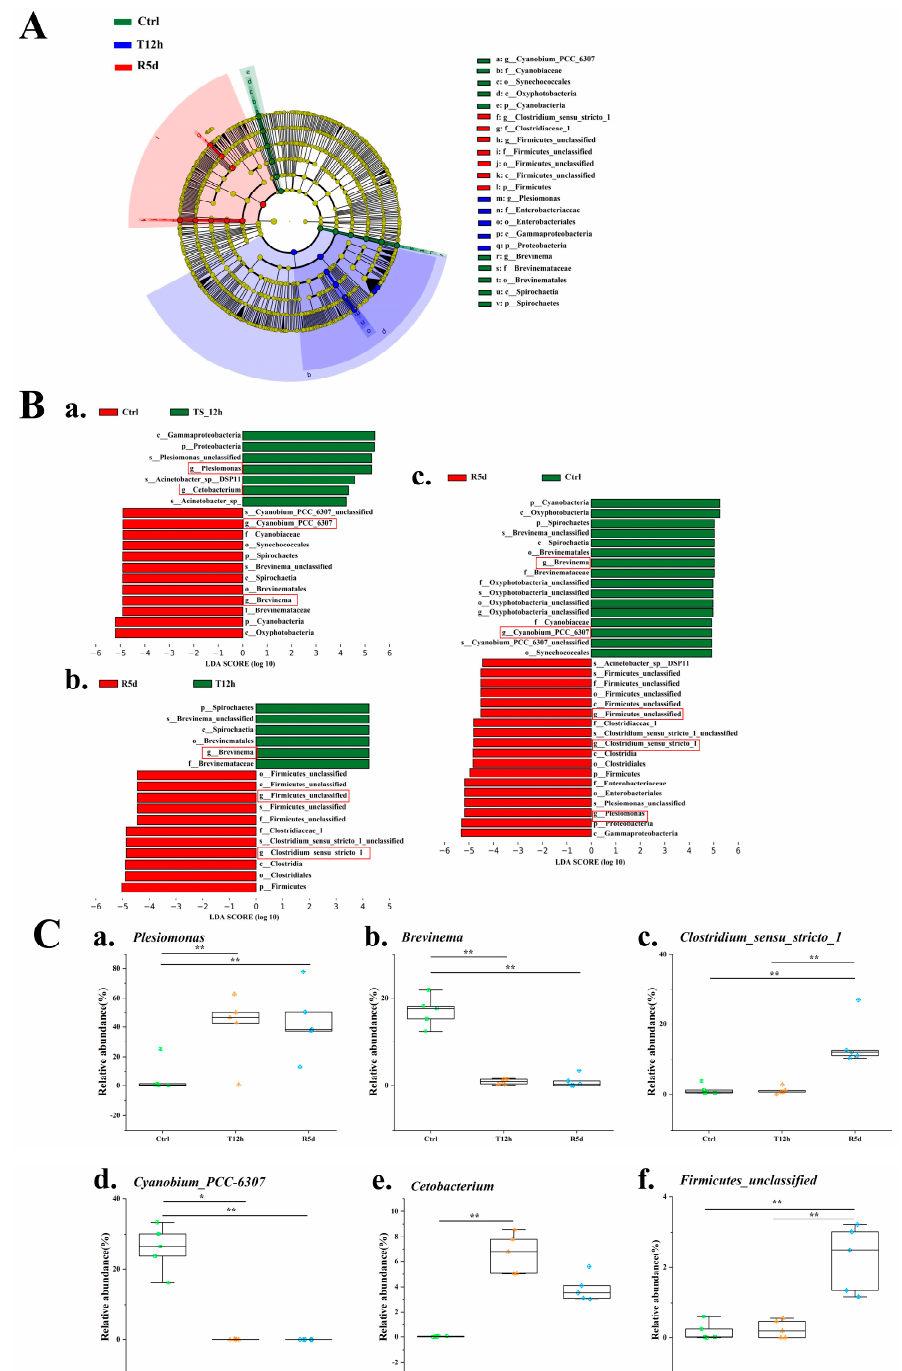
Figure 6. Linear discriminant analysis effect size (LEfSe) analysis comparing abundances of bacterial taxa in the control (Ctrl), 12 h transport (T12h) and recovery (R5d) groups. The LDA score >4. ( A ) Cladogram based on LEfSe analysis. Green, blue and red represent taxa enriched in the Ctrl, T12h and R5d groups. ( B ) Bacterial taxa with different abundances among groups. ( a ) Ctrl vs. T12h, ( b ) Ctrl vs. R5d, ( c ) T12h vs. R5, and ( d ) by Kruskal–Wallis test. ( C ) Relative abundances of dominant bacteria at the genus level ( a – f ) in the Ctrl, T12h and R5d groups. *, **: significant differences between the control and treatment groups (Kruskal–Wallis H test, *: p < 0.05, **: p < 0.01). Bacteria with significant changes in abundance were used to analyze the correlations with intestinal SOD, MDA, villus length and muscle layer thickness. The measured